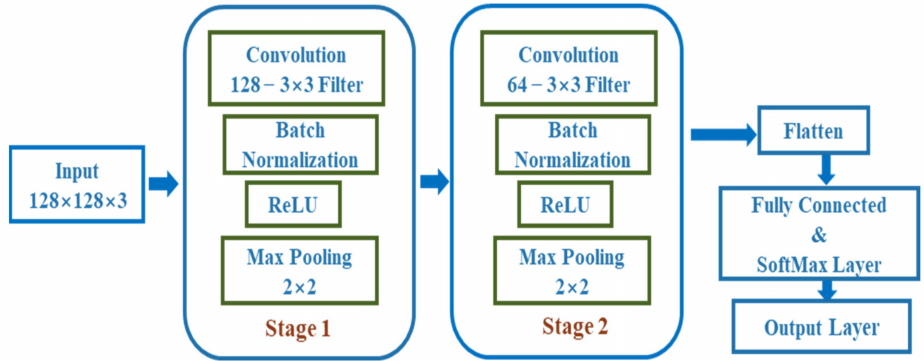
Figure 4. The modified architecture of the deep convolution neural